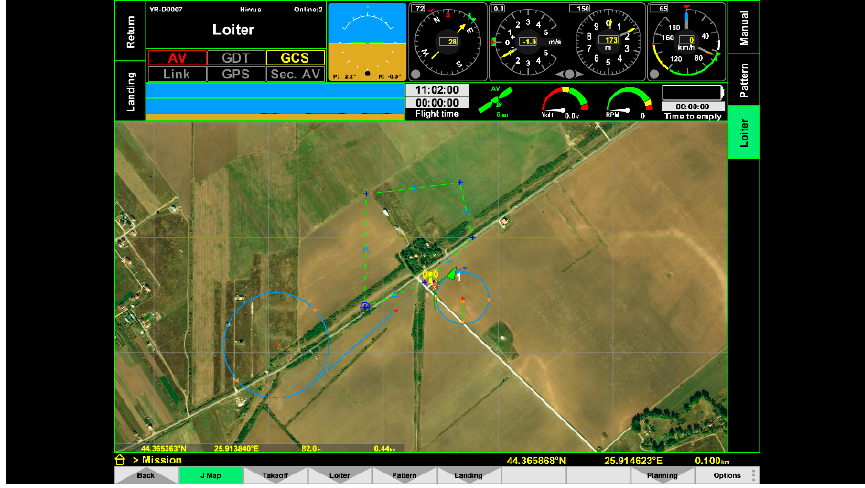
Figure 13. Loiter mode (tracking circles = blue). Green arrow = UAV.